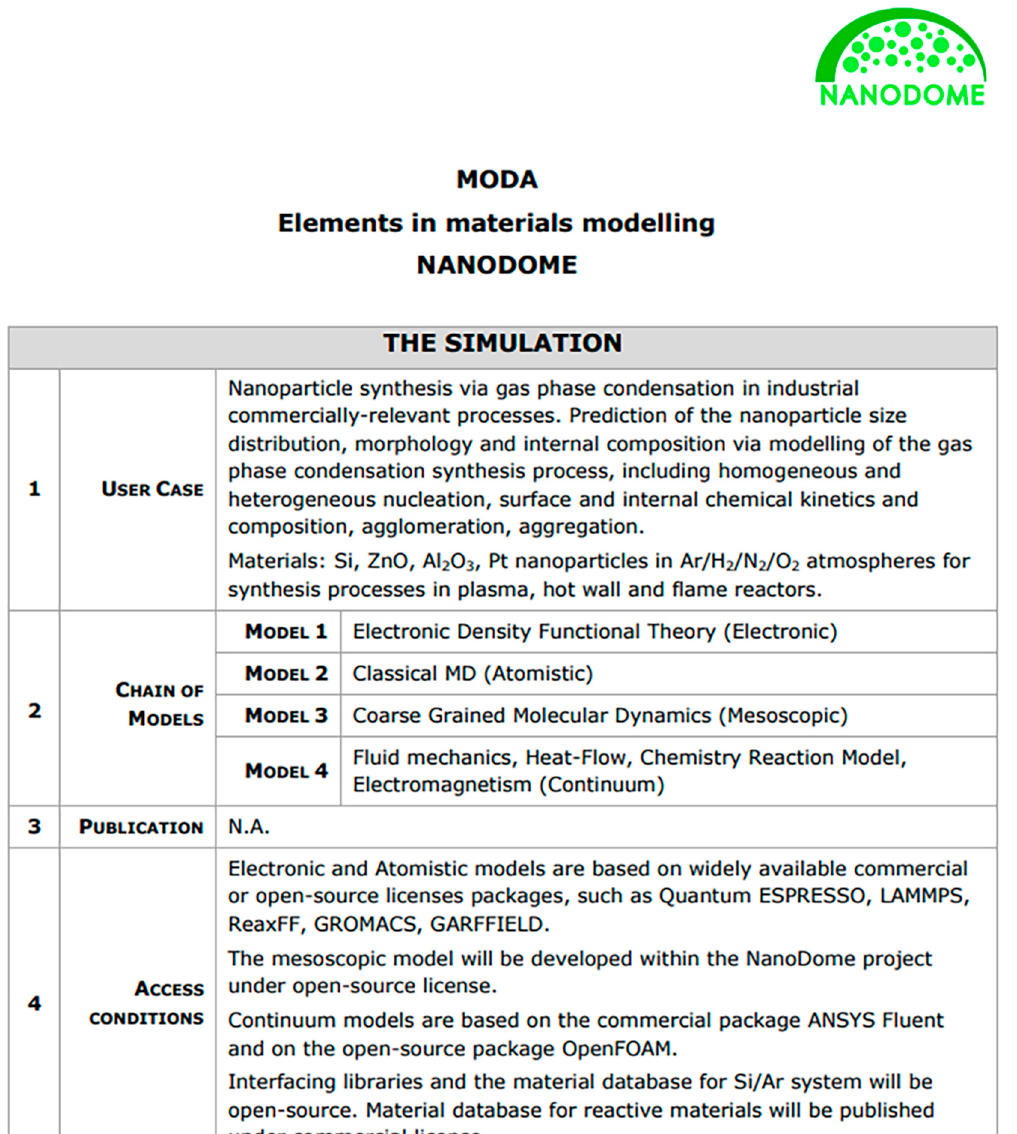
Figure 5. An example MODA template for nanoparticle synthesis and computational prediction of the size and size distribution.